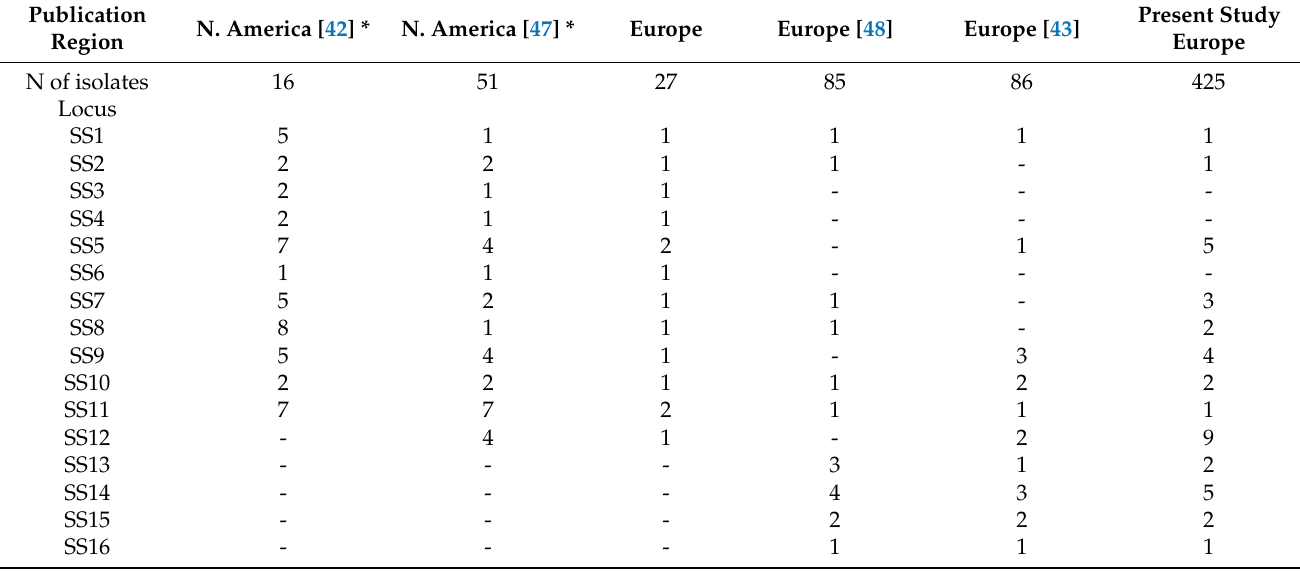
Table 9. Number of observed alleles in different microsatellite loci in Northern Hemisphere